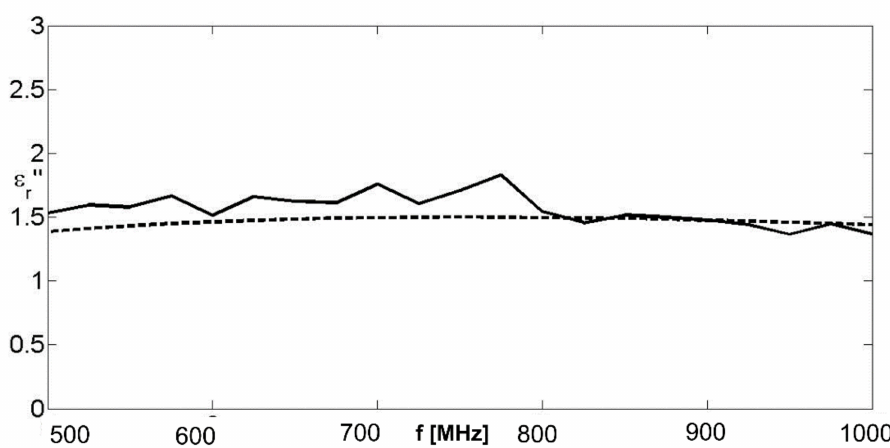
Figure 10. Imaginary part of the equivalent complex permittivity for a Debye dispersion law. Solid line: retrieved value; dashed line: actual value. Noisy data with SNR = 20 dB.